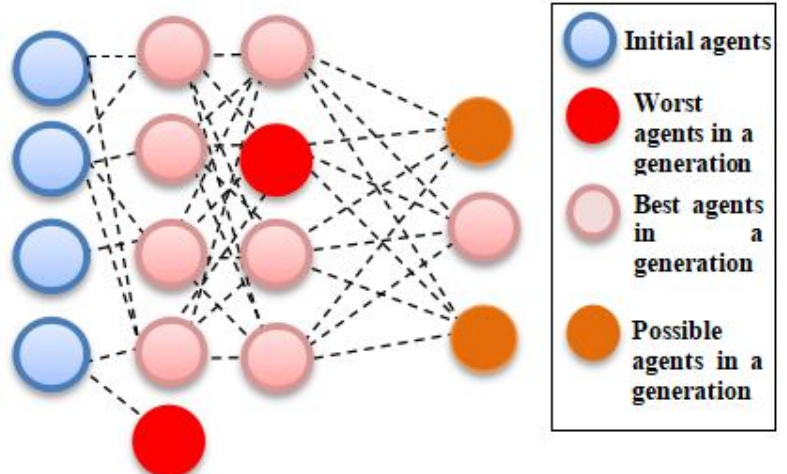
Figure 1. Evolutionary tree-based pipeline optimization tool (TPOT) algorithm, in which each best agent generation generates the next generation.